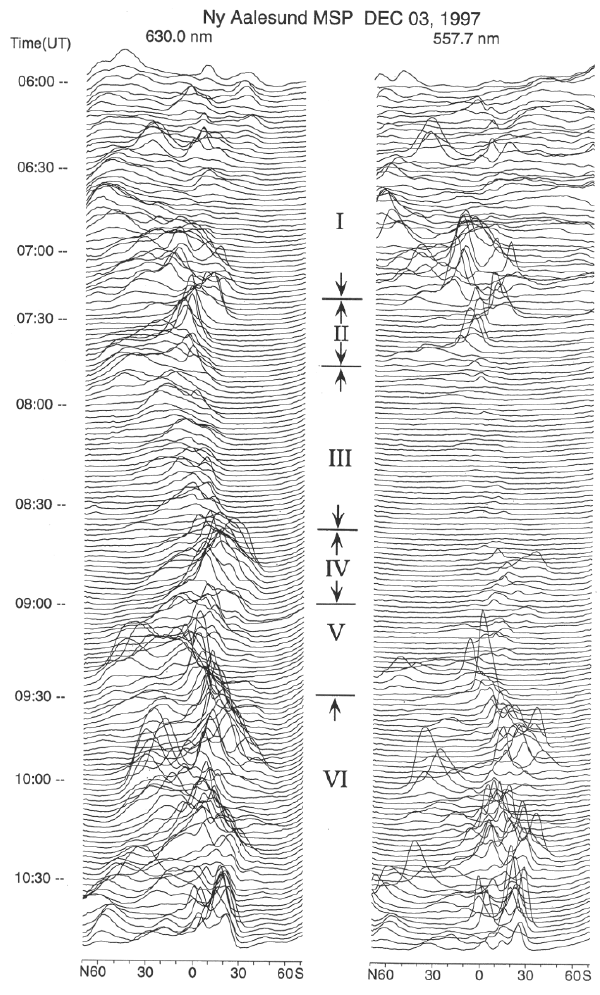
Figure 3 Fig. 3. Meridian scanning photometer (MSP) observations from Ny ˚Alesund during the interval 05:55–11:00 UT. Left and right columns show stacked plots of line of sight intensity vs. zenith angle for the wavelength channels at 630.0 and 557.7nm, respectively. Intervals showing different auroral characteristics are